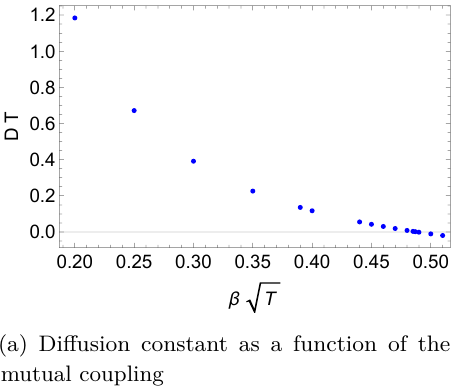
Figure 8 . The diffusion constant D as a function of ˆ β has been plotted above on the left. Note that the diffusion constant becomes negative around ˆ β ≈ 0 . 48 . The right plot shows that the upper bound in (3.10) is half-saturated at small ˆ β